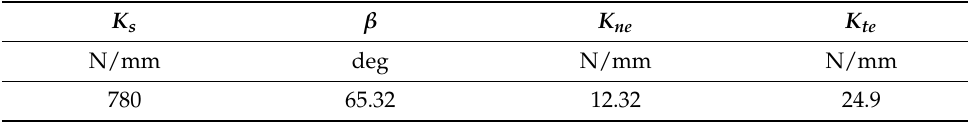
Table 2. Specific cutting force